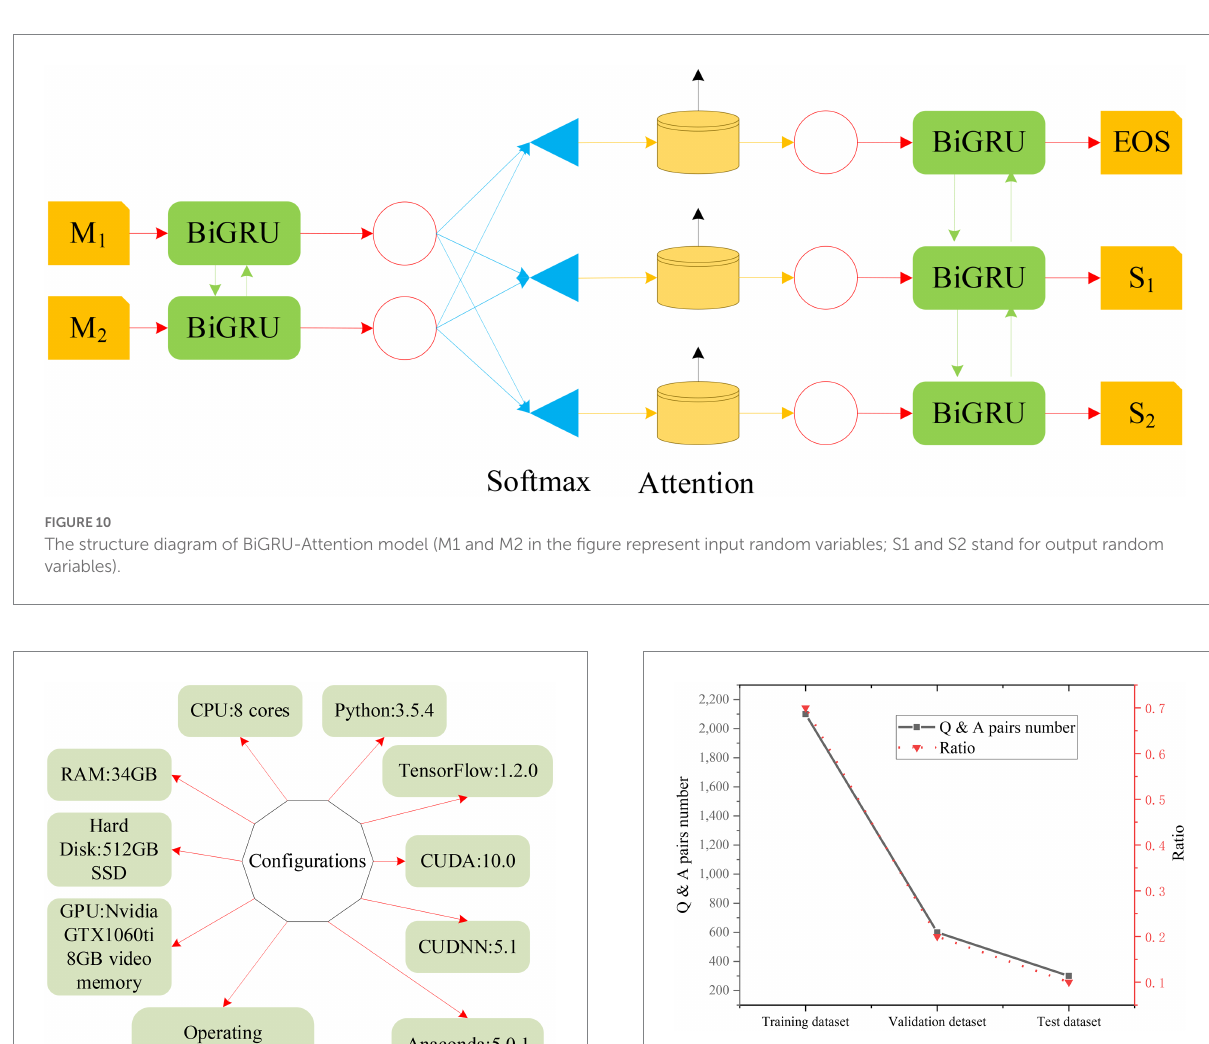
FIGURE 13 Example image of the questions.